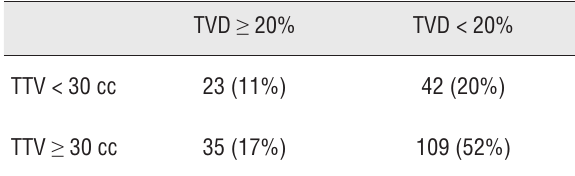
Table 2 - No. patients organized by TvD and